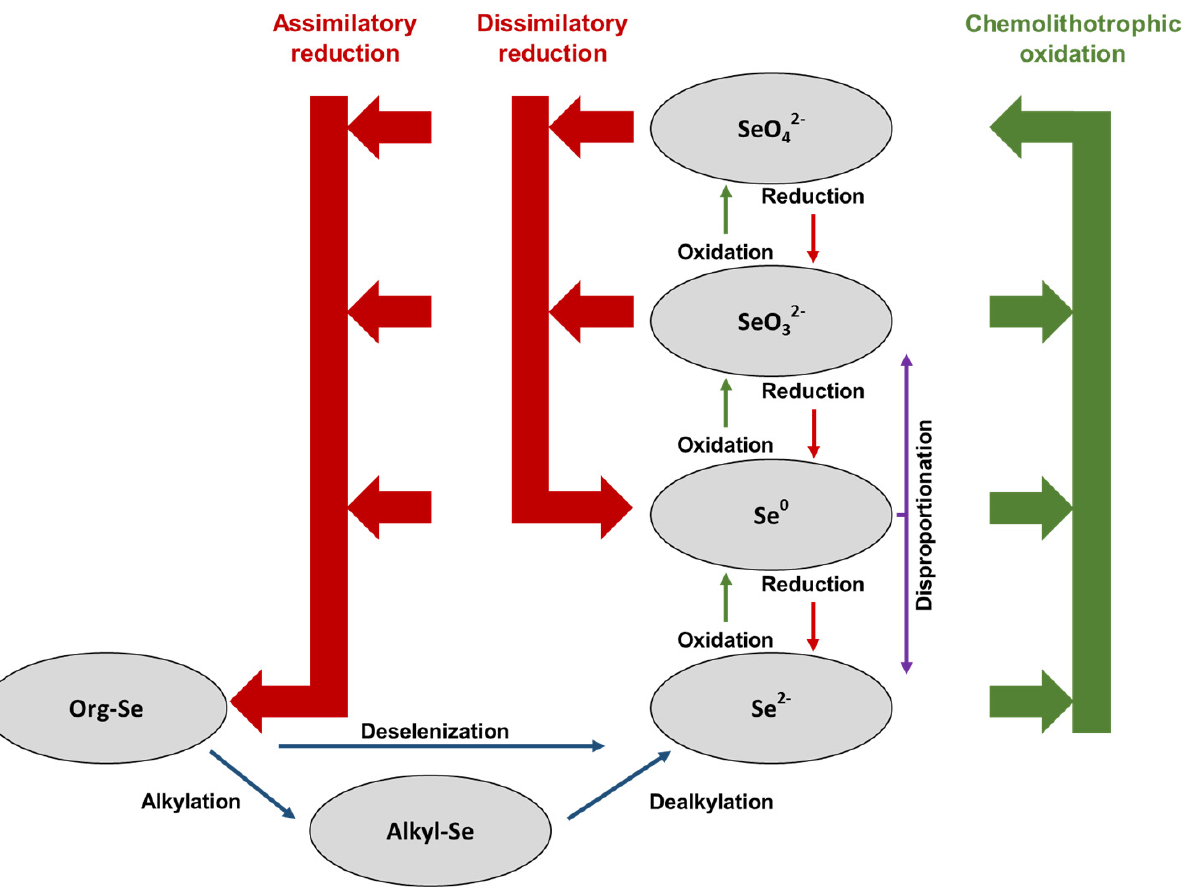
Figure 8. Selenium transformations in nature.